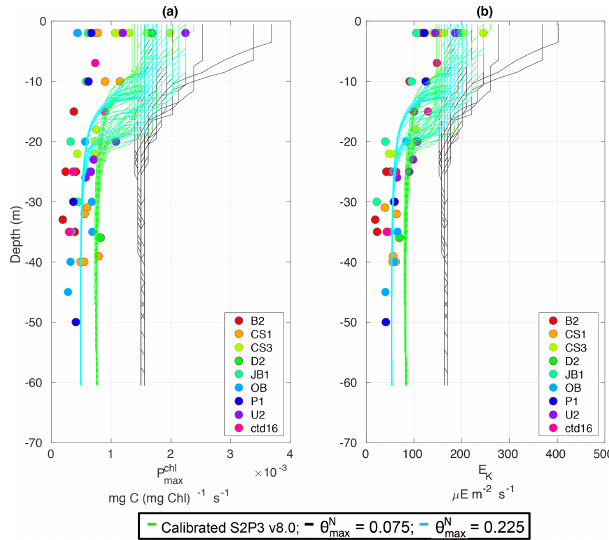
Figure C9. Observations from the cruises CD173 and JR98 in dif- ferent locations in the Celtic Sea, including the calibrated S2P3 v8.0 model (green lines), experiments θ N max = 0 . 075 (black lines) and θ N max = 0 . 225 (cyan lines) form (a) chlorophyll a specific maximum light-saturated photosynthesis rate parameter ( E k